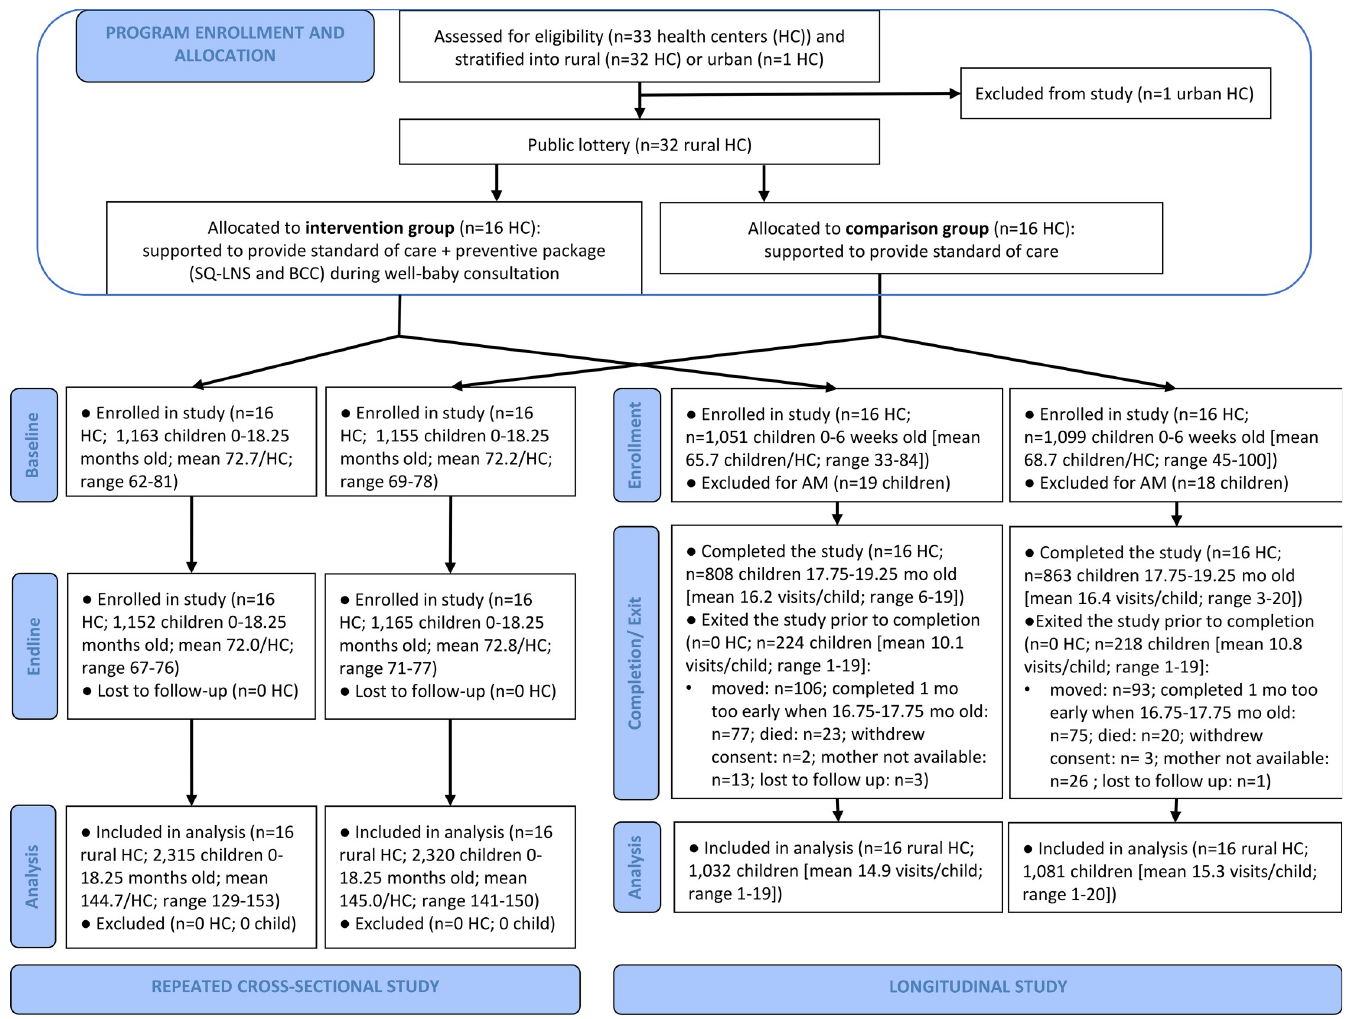
Fig 2. Trial profile for repeated cross-sectional study and longitudinal study. AM was defined as WLZ < − 2 at enrollment and at the first follow-up. AM, acute malnutrition; BCC, behavior change communication; HC, health center; SQ-LNS, small-quantity lipid-based nutrient supplement; WLZ, weight-for-length